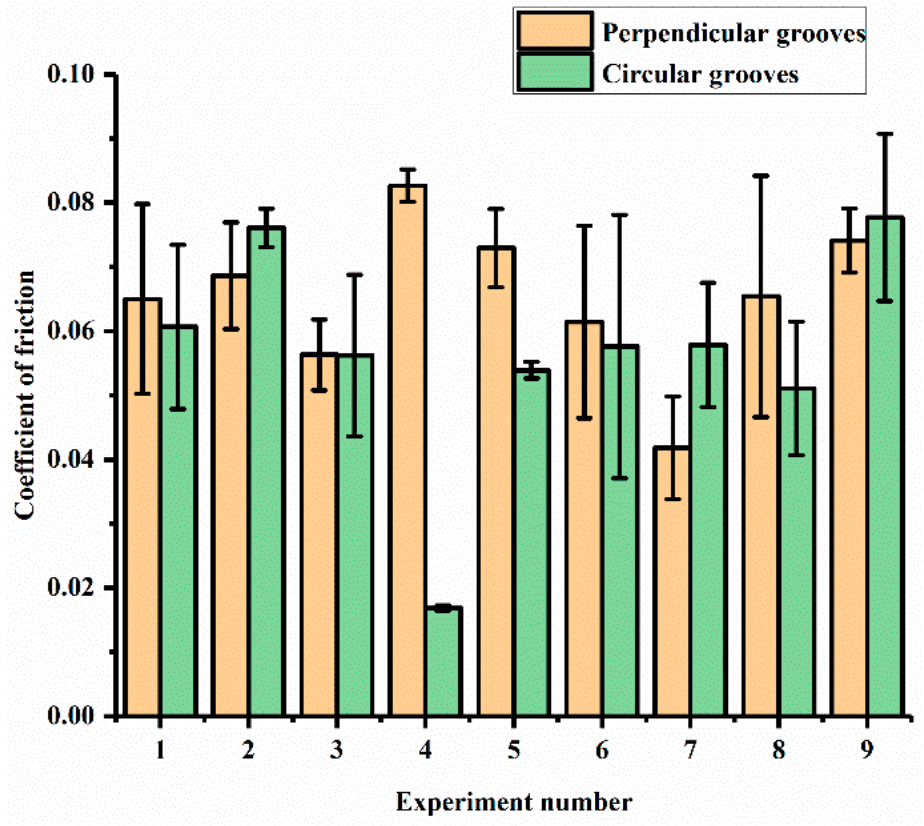
Figure 6. COF for perpendicular and circular grooves.